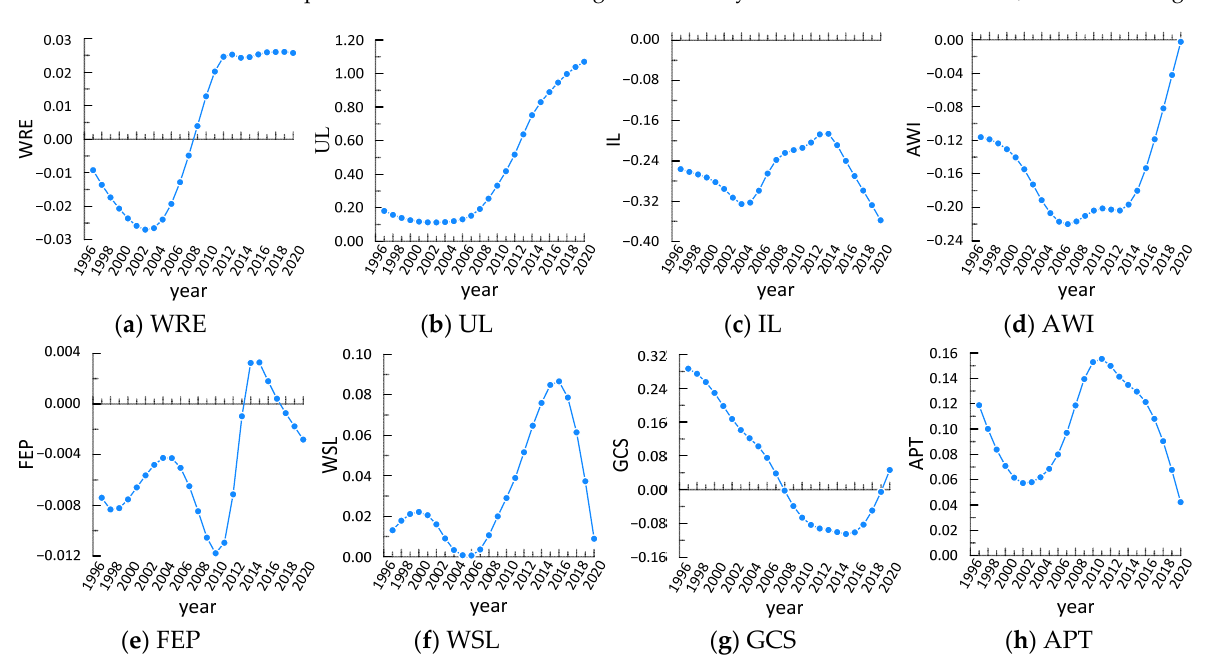
18 of 27 Figure 6. Spatial evolution characteristics of each influencing factor from 1997 to 2020. Note: The X- axis represents the direction of east longitude increments, that is, from west to east; the projection of XZ plane (red line) represents the variation trend of each influencing factor in different regions from west to east. The Y-axis represents the direction of north latitude increments, that is, from south to north; the projection of YZ plane (blue line) represents the variation trend of each influenc-